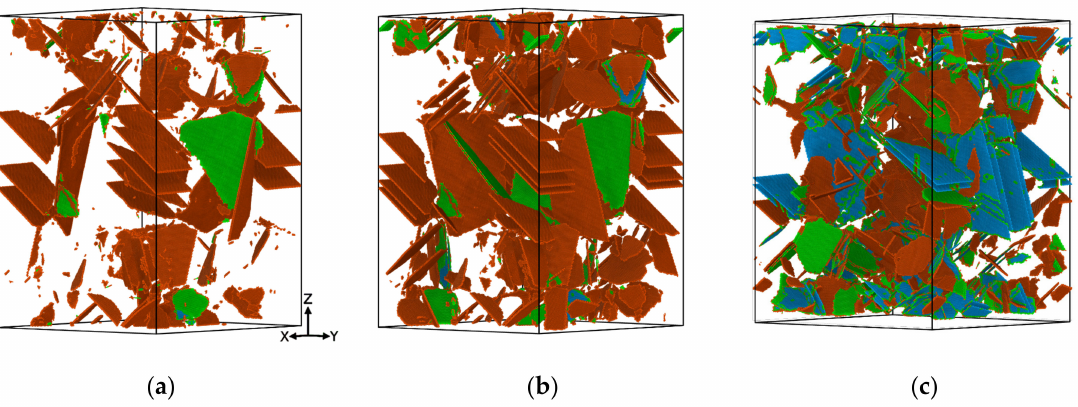
Figure 2. Structural defects in the sample strained to: ( a ) 3.7, ( b ) 4.5, and ( c ) 20.0%. Intrinsic stacking faults (ISFs) and twin boundaries with a thickness of one or more atomic planes are highlighted in red, green and blue, respectively.